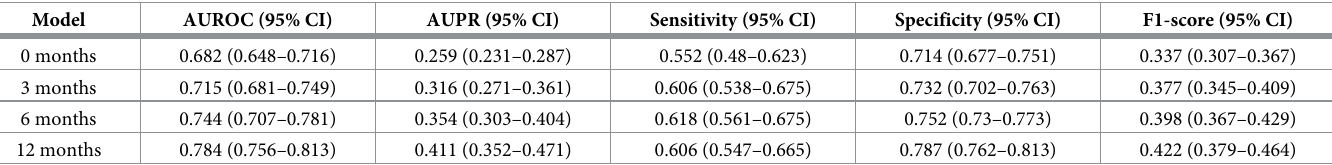
ESS = Endoscopic sinus surgery, 95% CI = 95% Confidence interval, AUROC = Area under the receiver operating characteristics curve, AUPRC = Area under the precision recall curve, F1-score is the harmonic mean between precision and